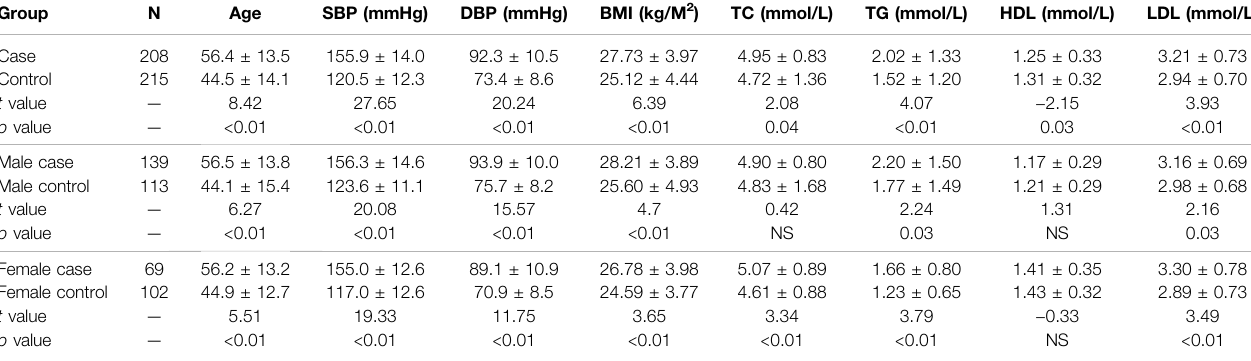
TABLE 2 | Basic clinical characteristics of EH cases and controls in Mongolian population. Group